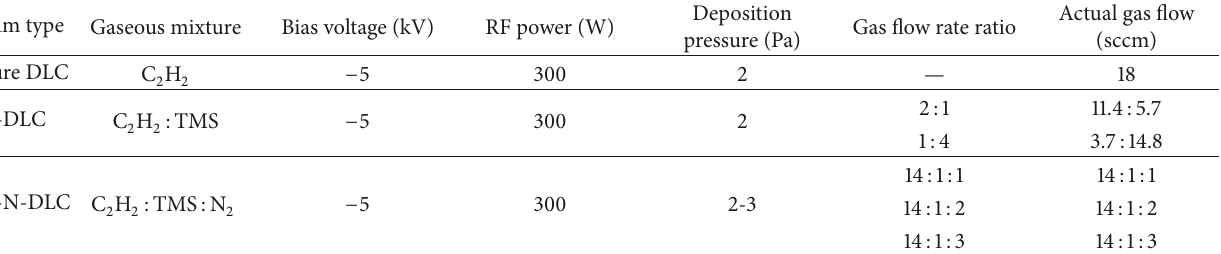
Table 1: Deposition of pure DLC, Si-DLC, and Si-N-DLC films.